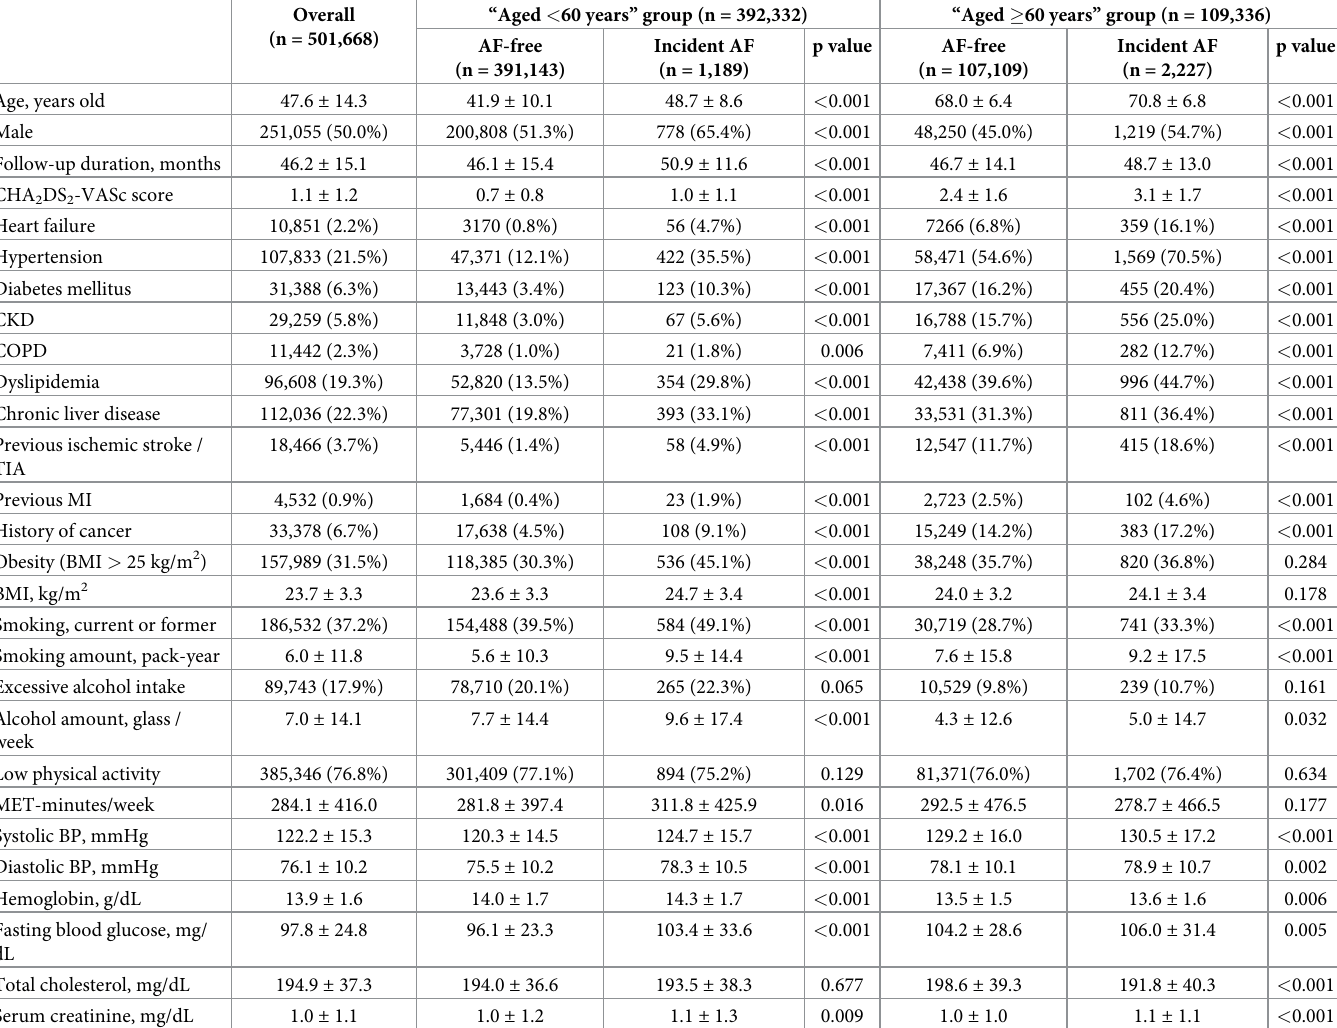
Table 1. Baseline